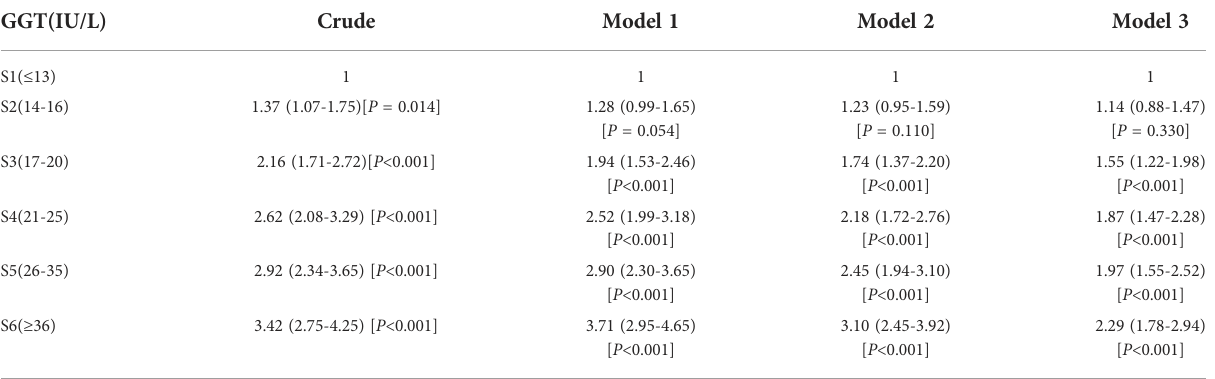
Model 1: adjusting for gender and age. Model 2: adjusting for all factors in model 1+ hypertension, BMI, alcohol drinking, smoking status. Model 3: adjusting for all factors in model 2+ TG and ALT.